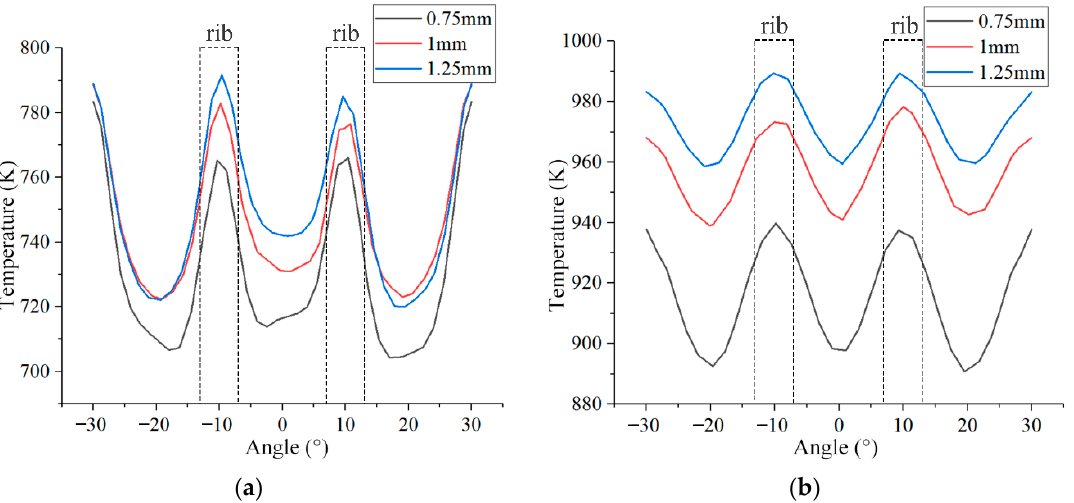
Figure 17. Circumferential variation in temperature on the inner wall under axial positions Z = 20 mm and Z = 175 mm. ( a ) Circumferential variation in temperature under Z = 20 mm; ( b ) circumferential variation in temperature under Z = 175 mm.